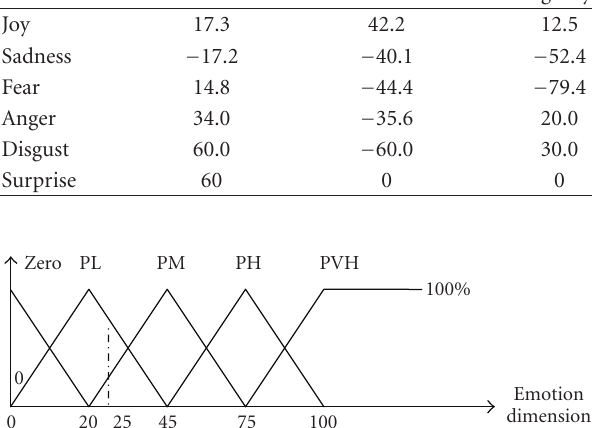
Figure 4: Fuzzy membership functions. L, M, and H stand for low, medium, and high. P and N mean positive and negative. The negative and positive sides are defined